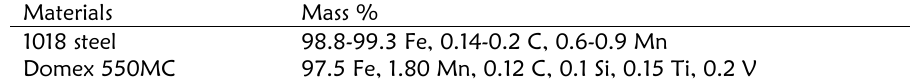
Table 2: Chemical composition of